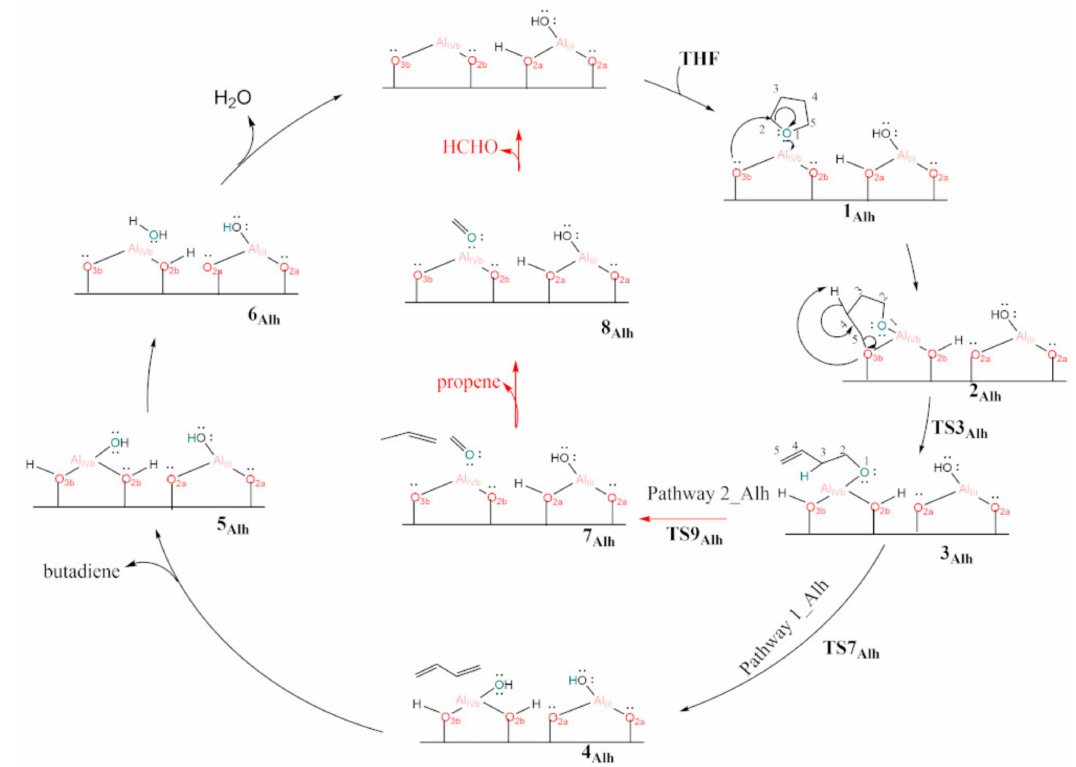
Scheme 5. Mechanism of THF reaction on Al IVb site of hydroxylated γ -Al 2 O 3 (110). Pathway